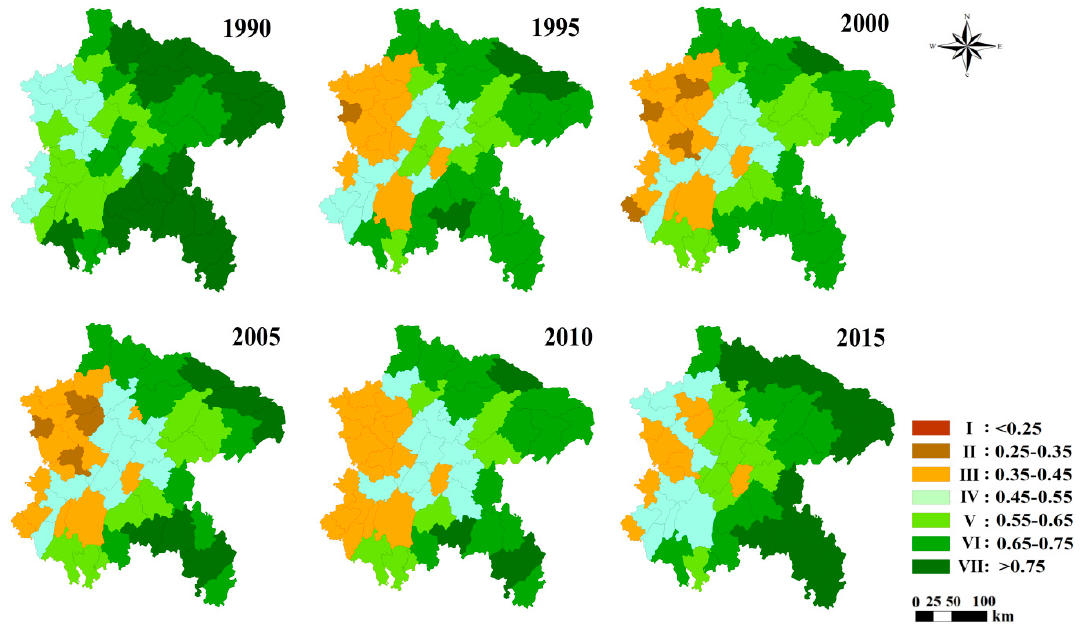
Figure 8. Assessment of the EHI for the study area from 1990 to 2015.